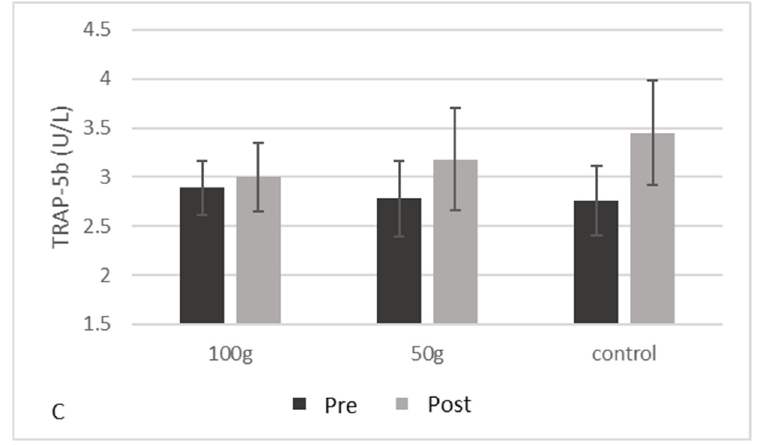
Figure 5. Blood osteocalcin ( A ), blood sclerostin ( B ), and blood TRAP-5b ( C ) in men before and after